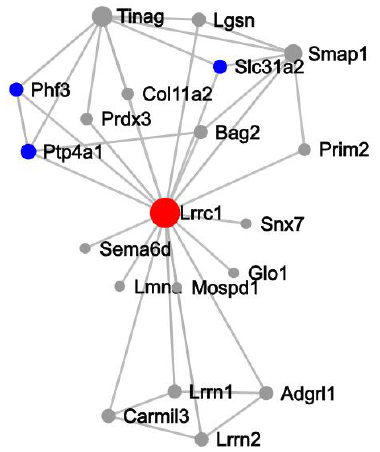
Figure 7. Key driver analysis (KDA) for the predicted target genes of the stably enriched DEmiRs. The result showed that Lrrc1 was the most prominent (primary) hub among the target genes, Tnag and Smap1 were the secondary hubs, and Ptp4a1 , Phf3 , Lgsn , Slc31a2 , Bag2 , Lrrn1 , Adgrl1 , Lrrn2 , and Camil3 were the tertiary hubs.